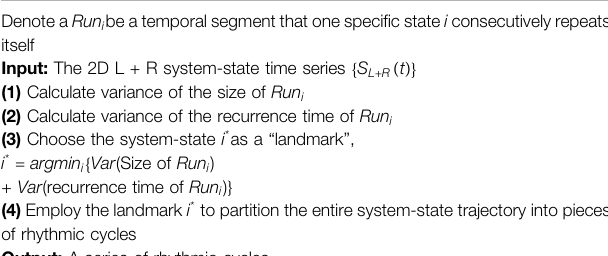
Algorithm 2: Landmark